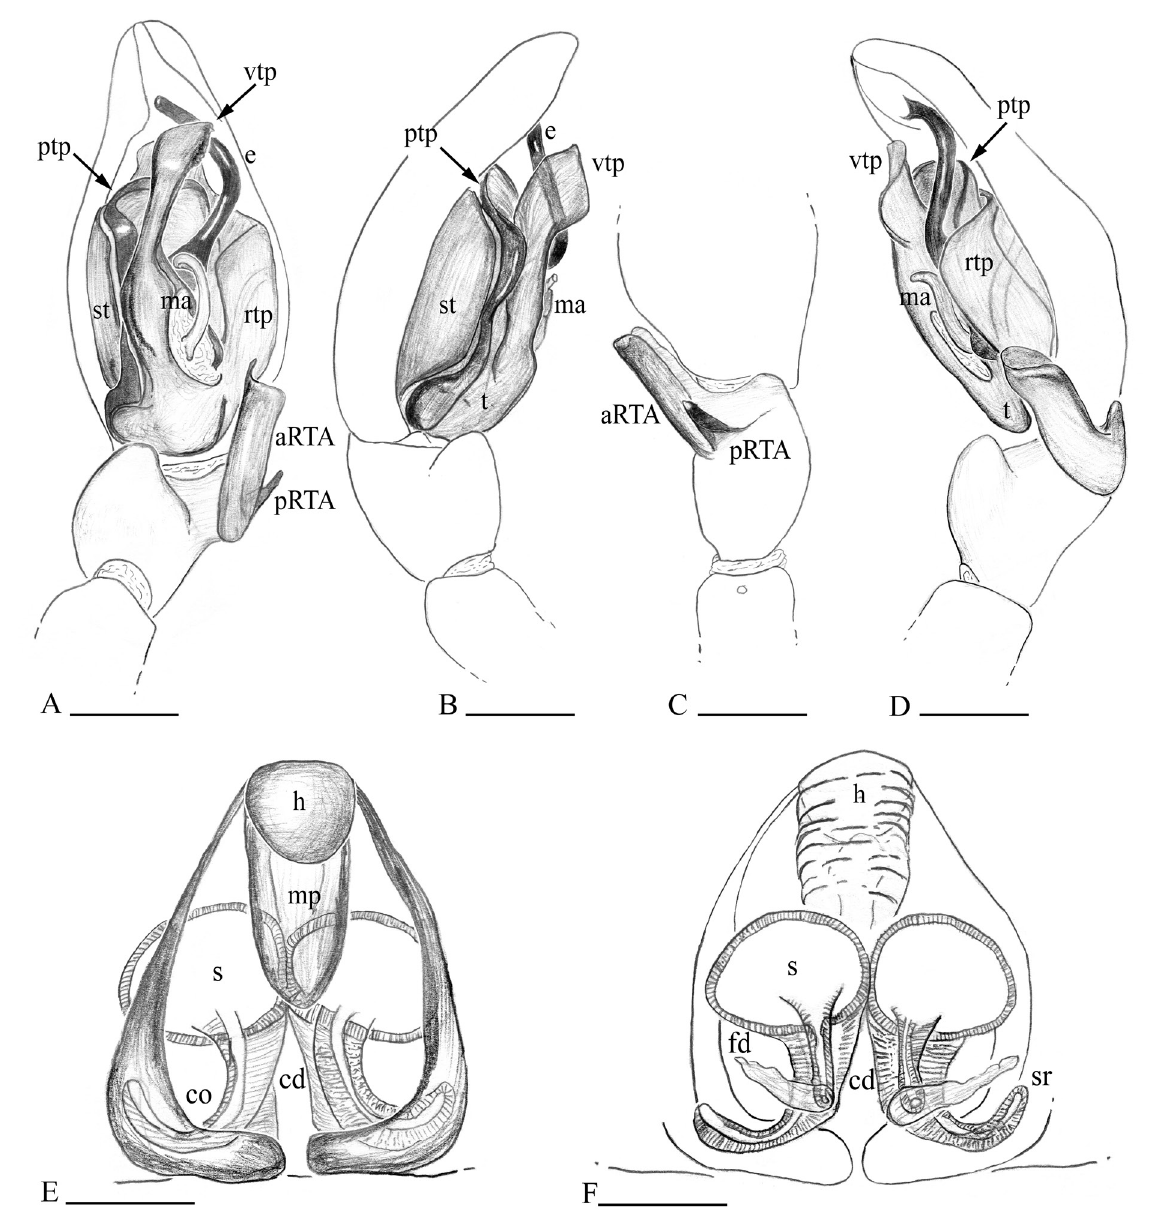
Fig. 5. Anyphaena natachae sp. nov., paratypes (CNAN-T01562). A . ♂, pedipalp, ventral view. B . ♂, pedipalp, prolateral view. C . ♂, pedipalp, dorsal view. D . ♂, pedipalp, retrolateral view. E . ♀, epigynum, ventral view. F . ♀, epigynum, dorsal view. Scale bars: A–D = 0.2 mm; E–F = 0.1